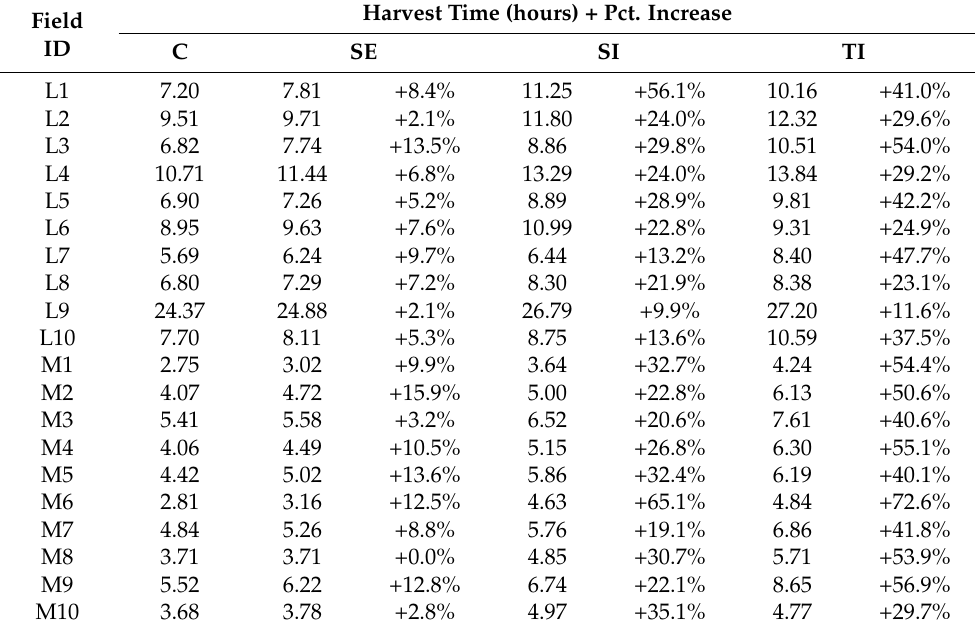
Table 4. Estimated harvest times for the four harvesting cases and the percentage of time increase for the SH cases compared to conventional